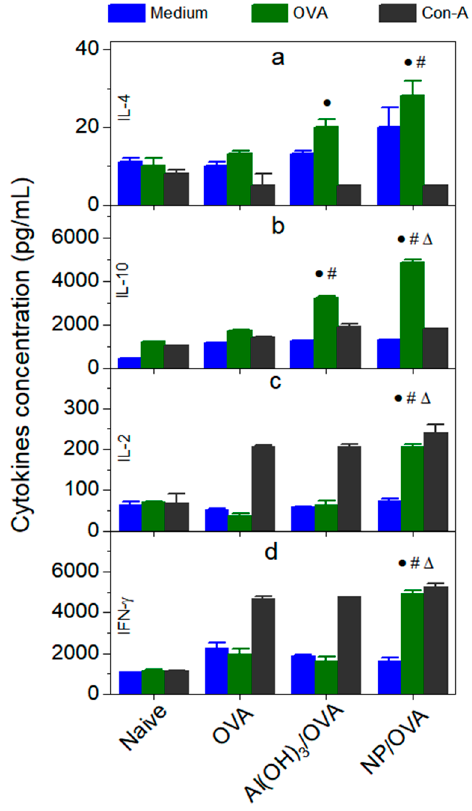
Figure 7. Production IL-4 ( a ), IL-10 ( b ), IL-2 ( c ) and IFN- γ ( d ) (pg/mL) elicited by cultured spleen cells obtained from naïve or animals immunized with ovalbumin (OVA), Al(OH) 3 /OVA, PMMA/DODAB/OVA (NPs/OVA). p < 0.05 compared to the naive group ( • ), p < 0.05 compared to the OVA group (#), p < 0.05 compared to the Al(OH) 3 /OVA group ( ∆ ). Splenocytes were challenged with OVA, medium (negative control) and concanavalin-A (Con-A) (positive control). In the presence of DODAB and poly(diallyl dimethylammonium chloride) (PDDA), emulsion polymerization of MMA yielded PMMA/DODAB/PDDA NPs [21,43,45]. These hybrid, PMMA-based NPs predominantly contained PMMA, a biocompatible polymer, displaying absence of cytotoxicity when tiny amounts of cationic components were used, PMMA/DODAB/PDDA [21] showed some differences in the type of immune response.